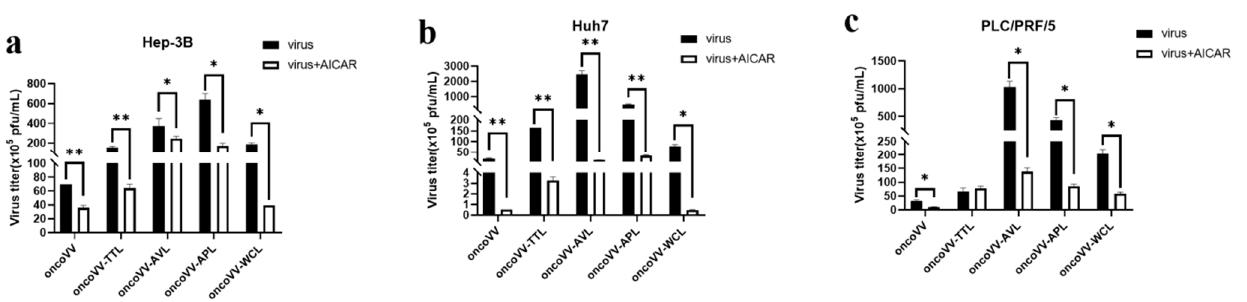
Figure 4. AlCAR affected vaccinia viruses replication in ( a ) Hep-3B, ( b ) Huh7, and ( c ) PLC/PRF/5 cells. Cells were maintained for 12 h and treated with AICAR (400 μ mol/L), followed by 5 MOI of oncoVV or oncoVV-lectin infection about 1 h later. The above samples were collected at 36 h postinfection. OncoVV served as the control. * p < 0.05, ** p < 0.01.